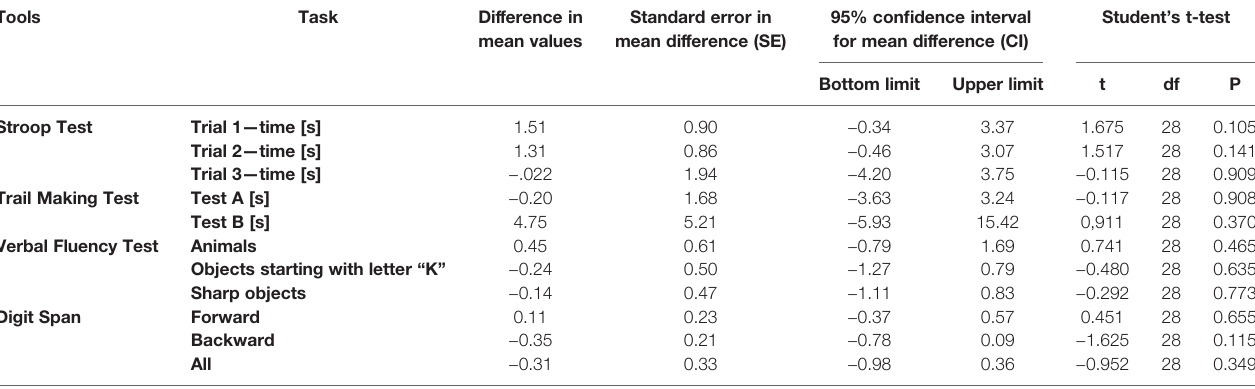
TABLE 4 | Comparison of cognitive function measurement results 3 months after the fi rst measurement in patients with schizophrenia and co-occurring metabolic syndrome.